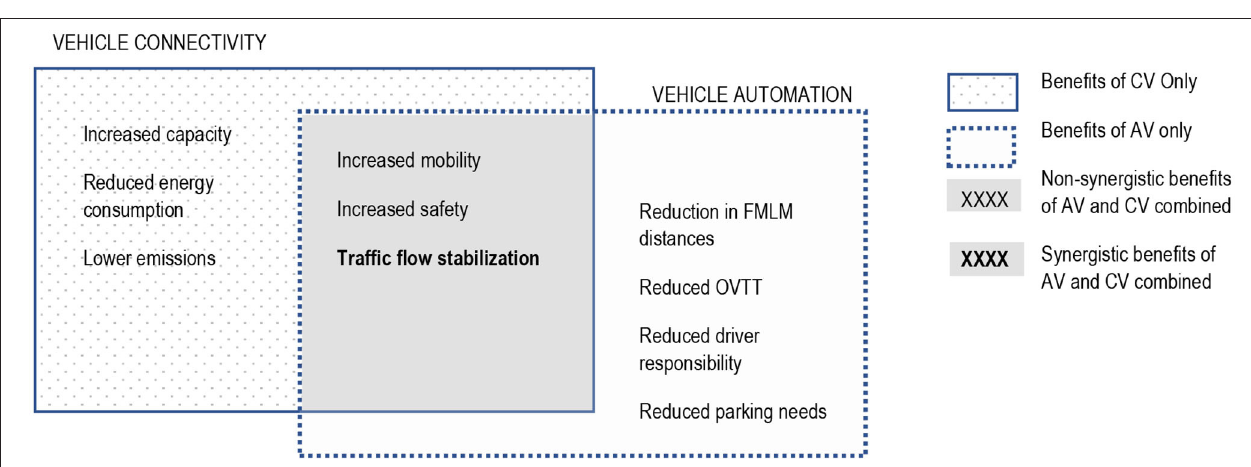
FIGURE 2 | CV and AV: Individual, overlapping, and synergistic